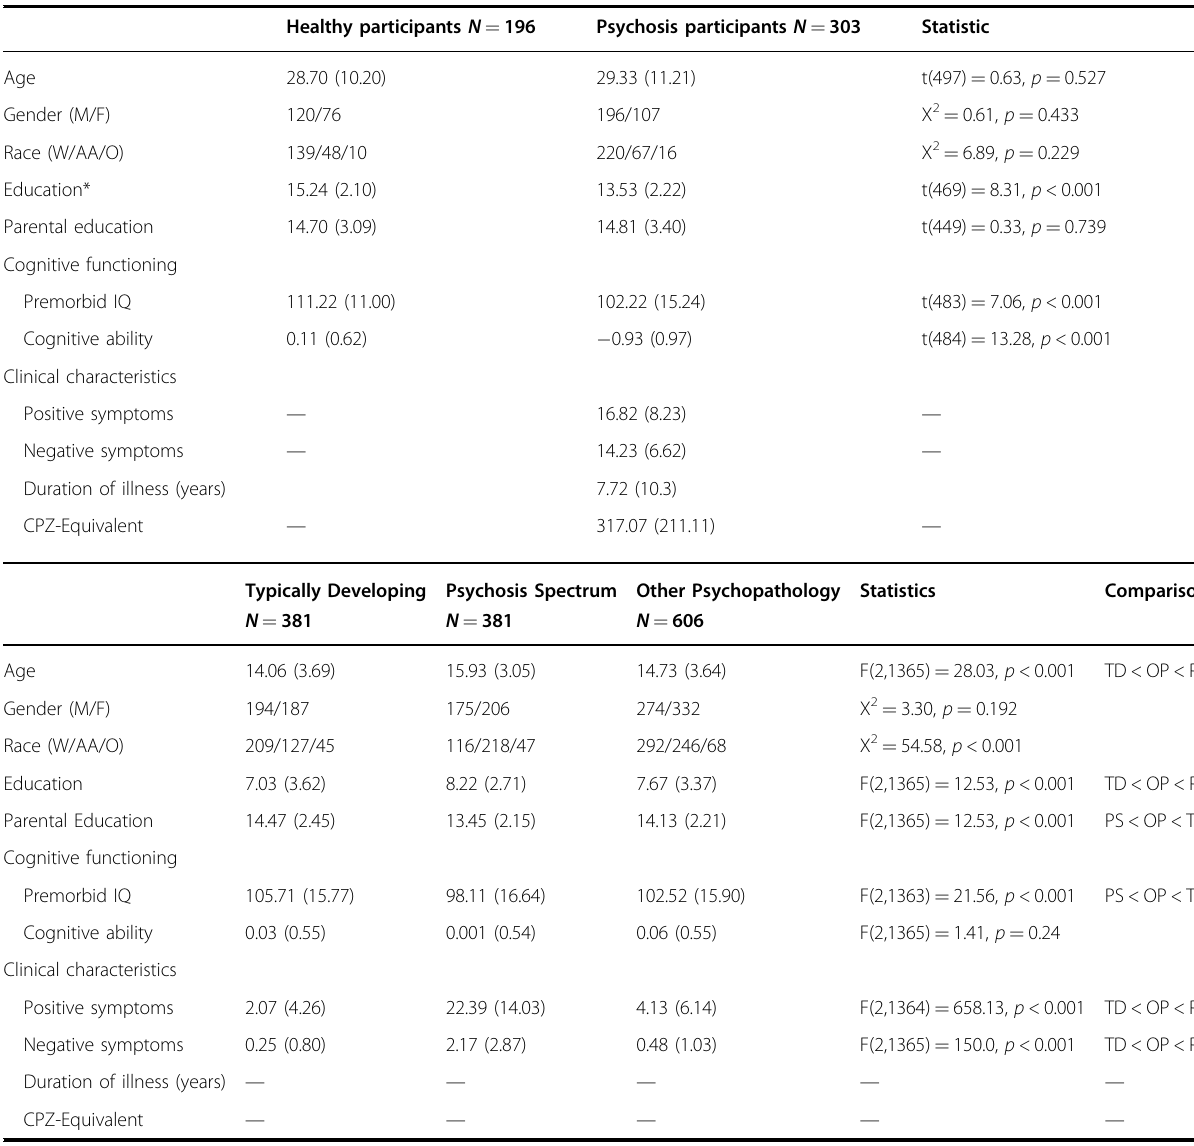
Table 1 Demographics. Healthy participants N = 196 Psychosis participants N = 303